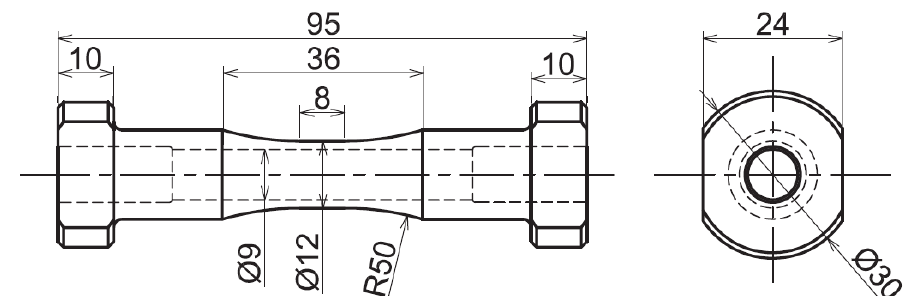
Figure 1: Shape and dimensions of test specimen (mm).